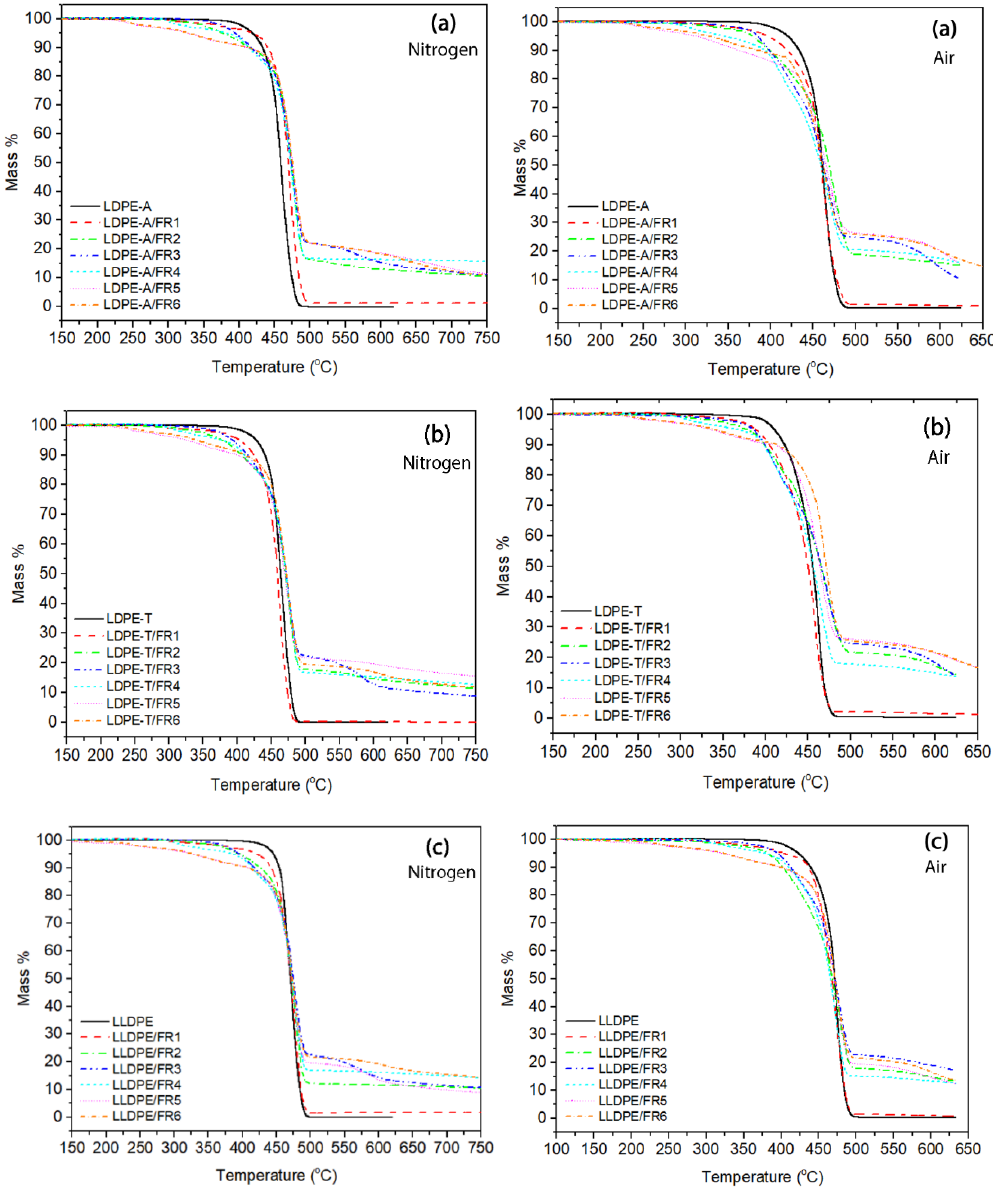
Figure 2. TGA curves under nitrogen and air of FR-containing compounds ( a ) LDPE-A, ( b ) LDPE-T, ( c ) LLDPE